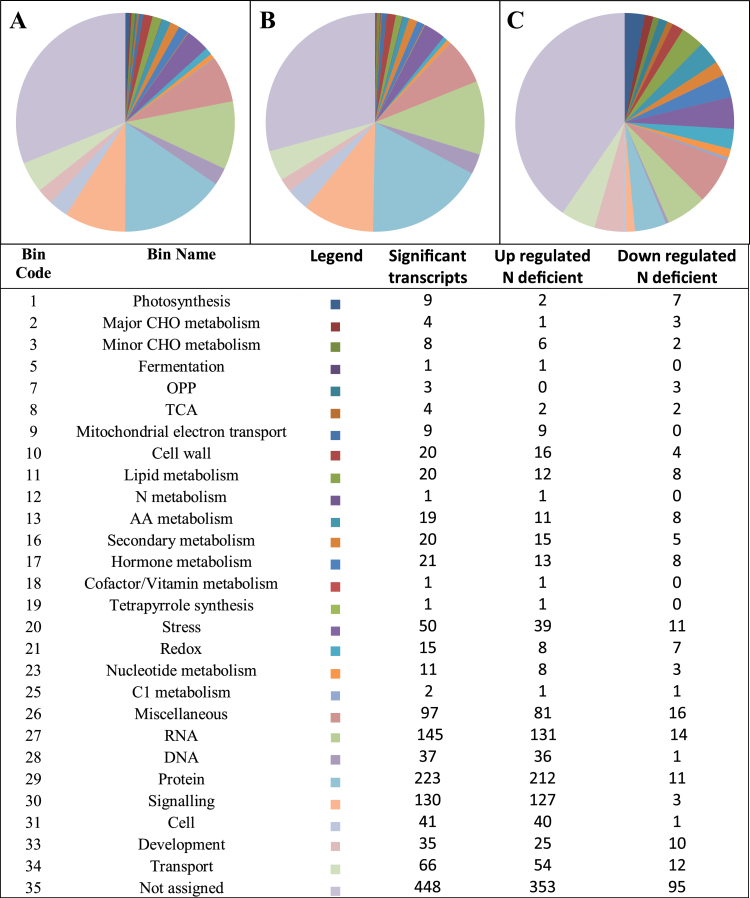
Functional classification of transcripts exhibiting significantly different abundance under N-replete or N-deficient conditions. Venn diagrams illustrate the relative numbers of transcripts that were significantly differentially abundant (A) or those more (B) or less (C) abundant under N deficiency. The table lists the MapMan bins containing differentially abundant transcripts and provides the number of transcripts in each bin.